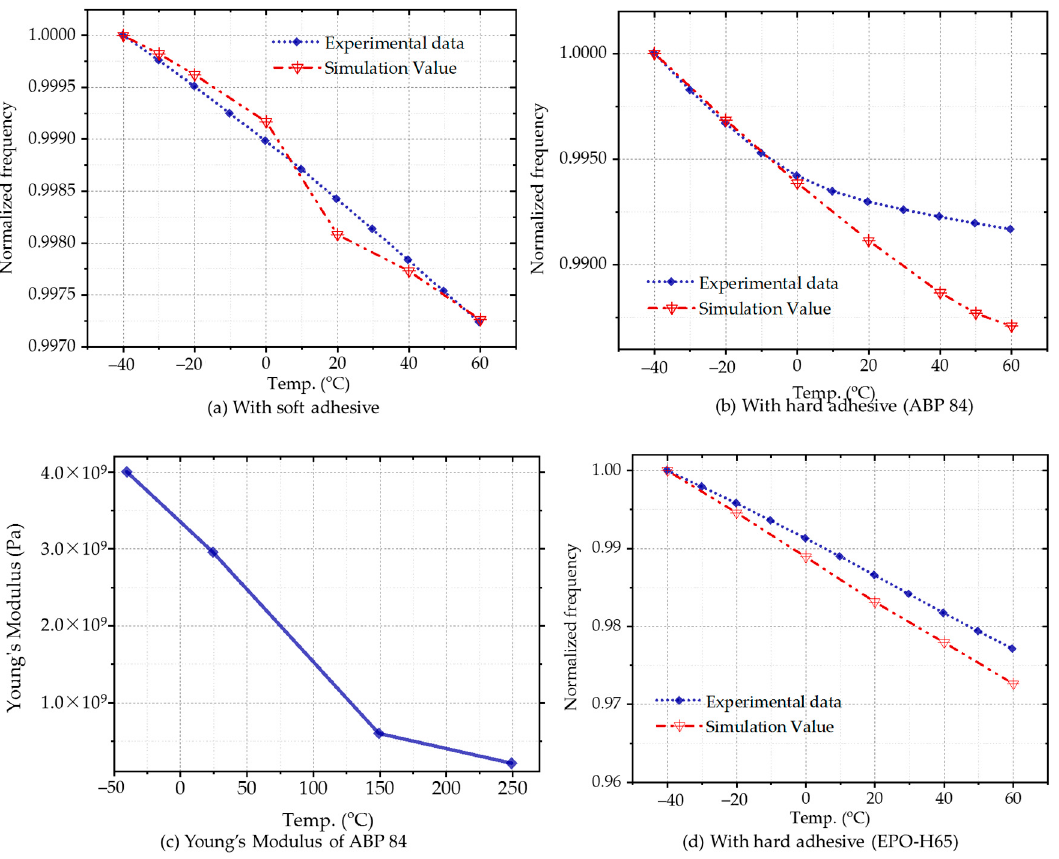
Figure 10. Comparing temperature characteristics between experimental and simulation results, ( a ) the data with soft adhesive; ( b ) the data with hard adhesive ABP 84-3JT; ( c ) Young’s Modulus of ABP 84-3JT applied in the simulation; ( d ) the data with hard adhesive EPO-H65.